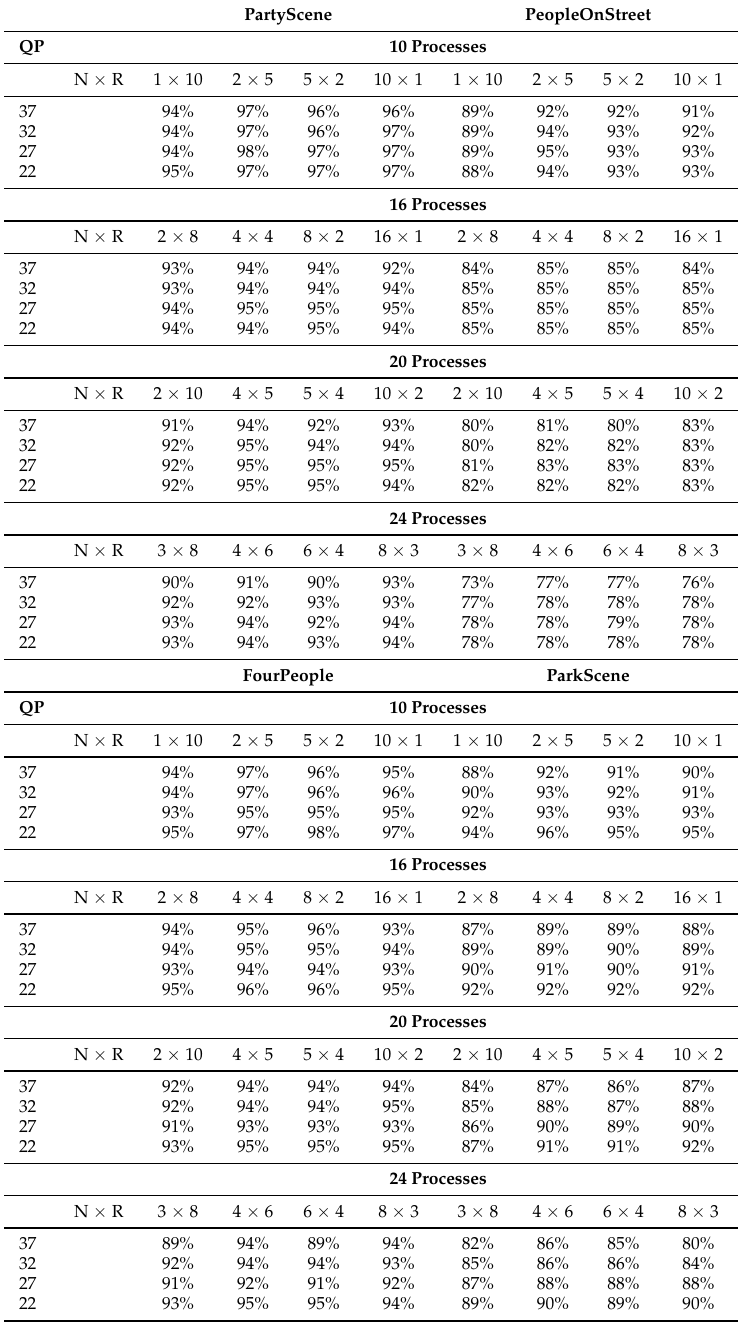
Table 9. Efficiency of the DSM-AI parallel